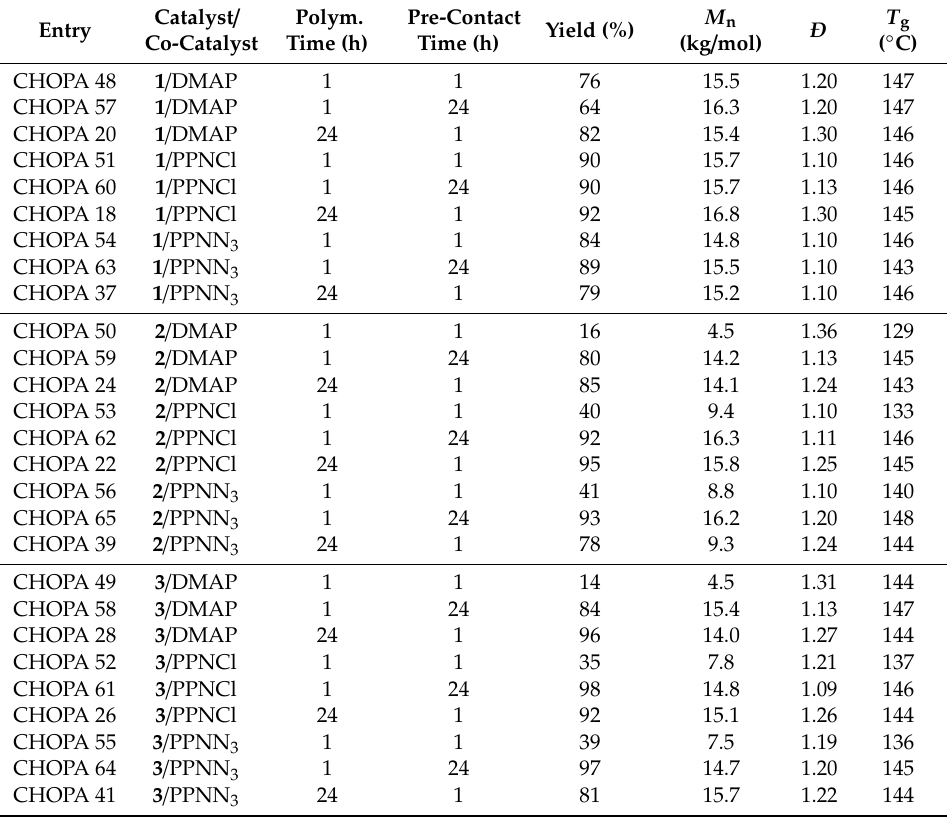
Table 5. CHO / PA copolymerization with di ff erent pre-contact times a